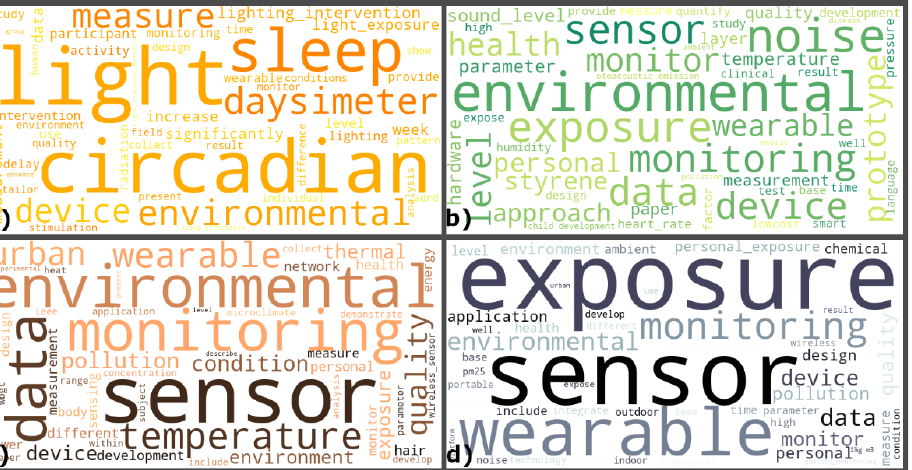
Figure 4. Exploratory Analysis with the word cloud of the most used terms in the title and abstract of the selected papers: ( a ) Visual EF; ( b ) Acoustic EF; ( c ) Thermal EF; ( d ) Air Quality EF.